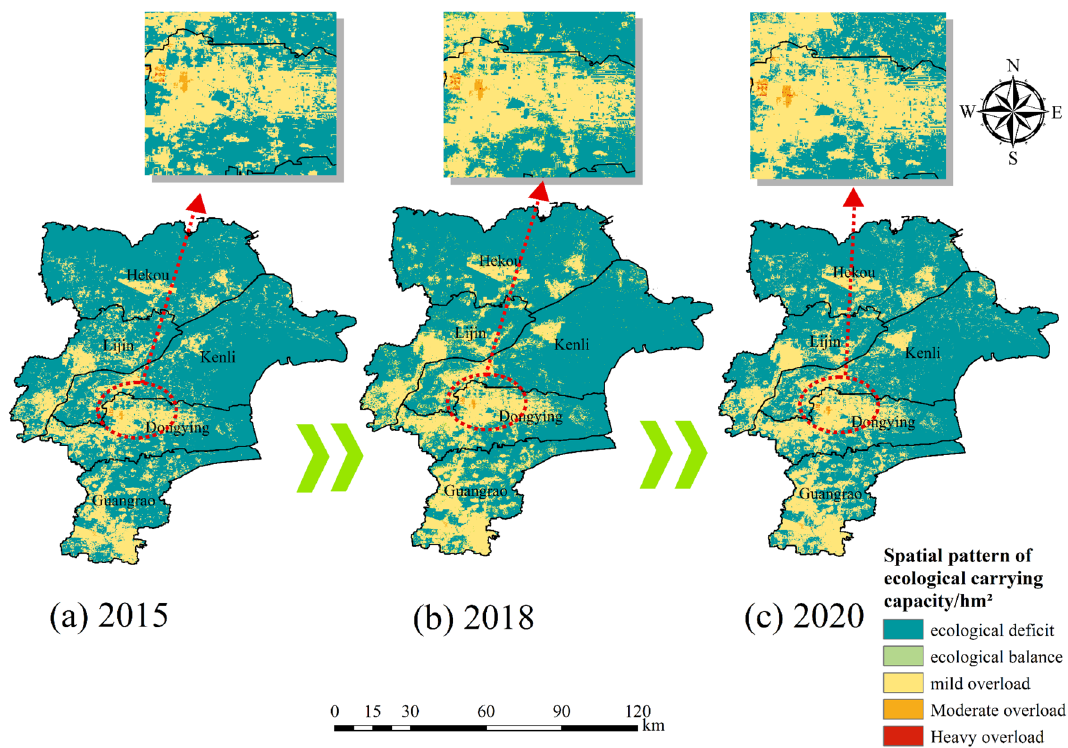
Figure 9. Spatial heterogeneity of ecological deficits in 2015 ( a ), 2018 ( b ) and 2020 ( c ). This figure was created with ArcGIS 10.2 (https:// suppo rt. esri. com/ en/ downl oad/